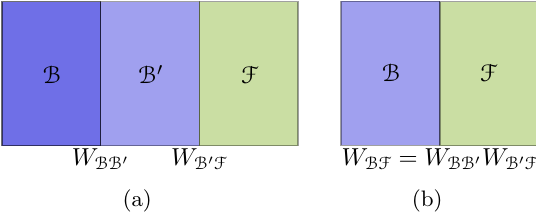
Figure 4 . (a) A GDW between B and B ′ and one between B ′ and F imply a GDW between B and F directly. B ′ is compressible between B and F